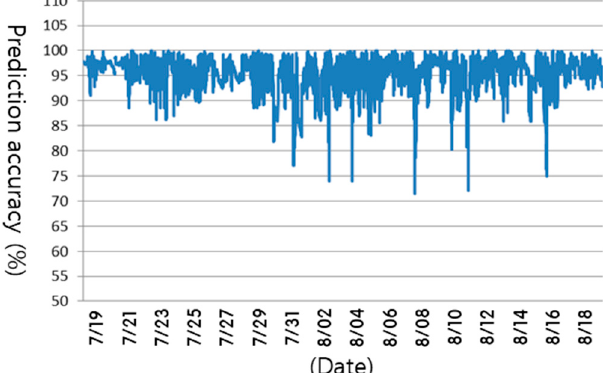
Figure 16. Daily results for the daylight illuminance on the workplane prediction accuracy.